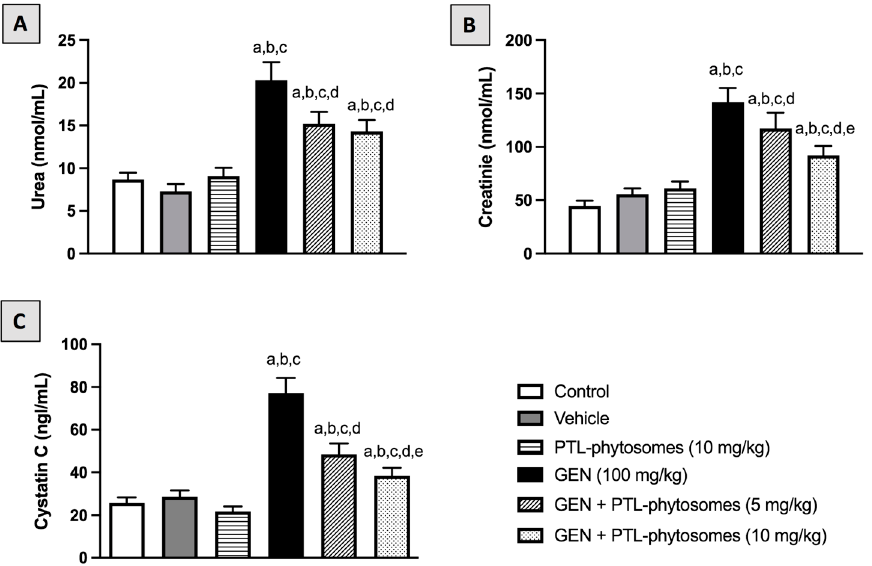
Figure 3. PTL-phytosomes ameliorated kidney functions in GEN-treated rats. Serum levels of ( A ): urea, ( B ): creatinine, ( C ): cystatin C were measured. Data are expressed as Mean ± SD ( n = 6). a: